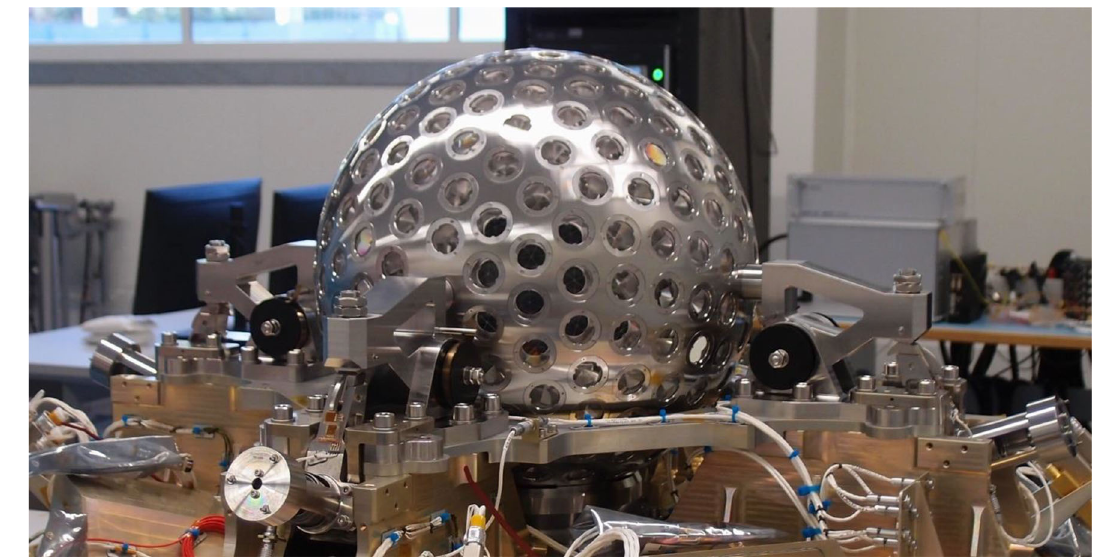
Fig. 1 The LARES 2 satellite before the launch mounted on the separation system